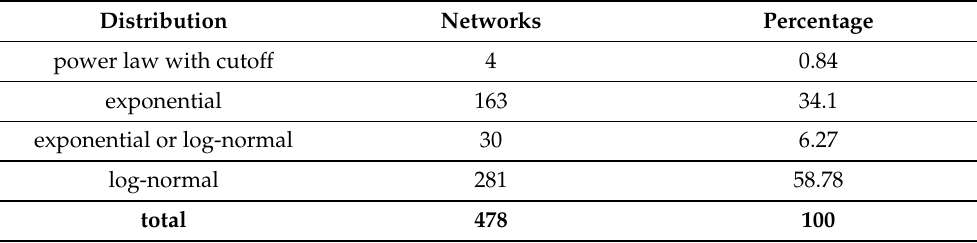
Table 2. The summary of fit of several distribution models to the node degree of PPI networks.